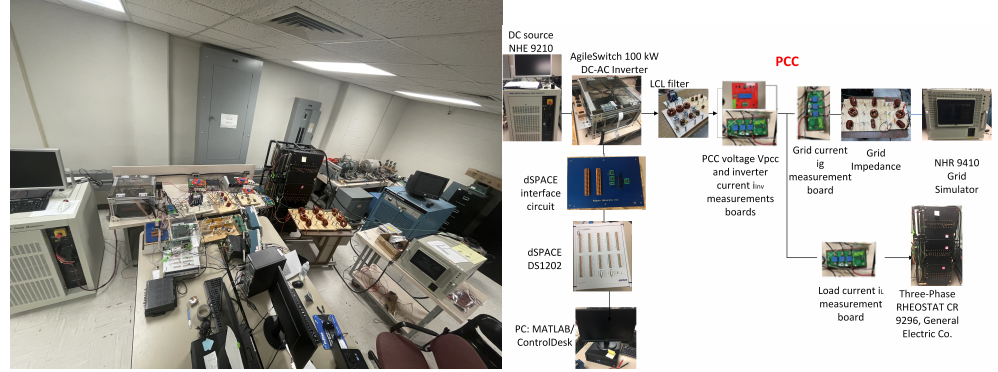
Figure 11. Hardware test